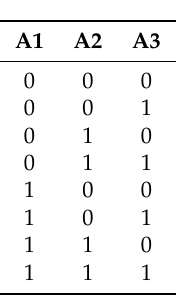
Table 1. Simulation Accredited